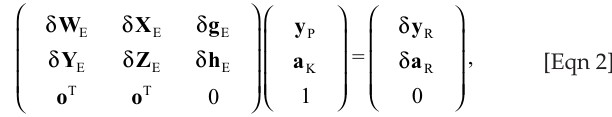
, pupillary T and retinal transverse planes T . A pencil of rays enters the eye at T K P R at T . The chromatic difference in image position δ y p P . Similarly, the chromatic difference in inclination of the chief rays at the retina δ a R